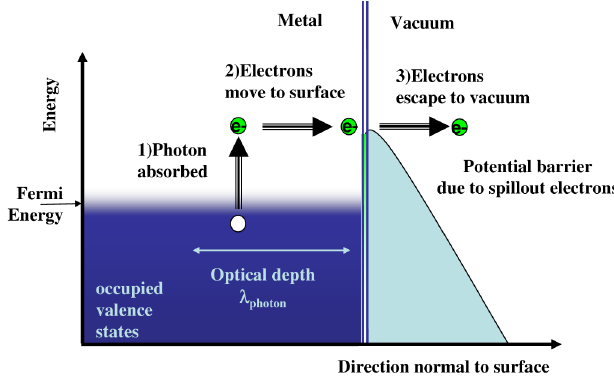
FIG. 1. (Color) Three-step model of